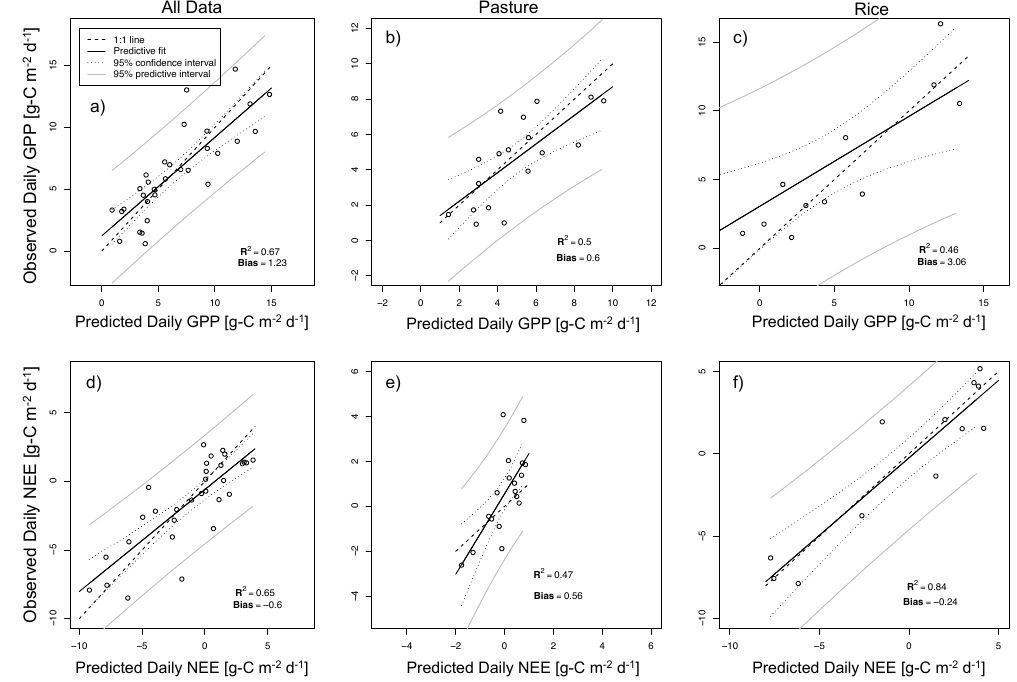
Figure 6. Validation data set. The mean PLSR models determined through the bootstrapping routine were tested on the Independent Valida-